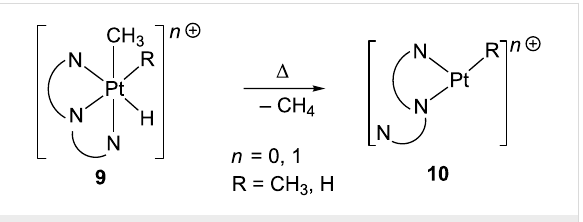
Scheme 10: Reductive elimination of methane from six-coordinate Pt(IV) complexes.